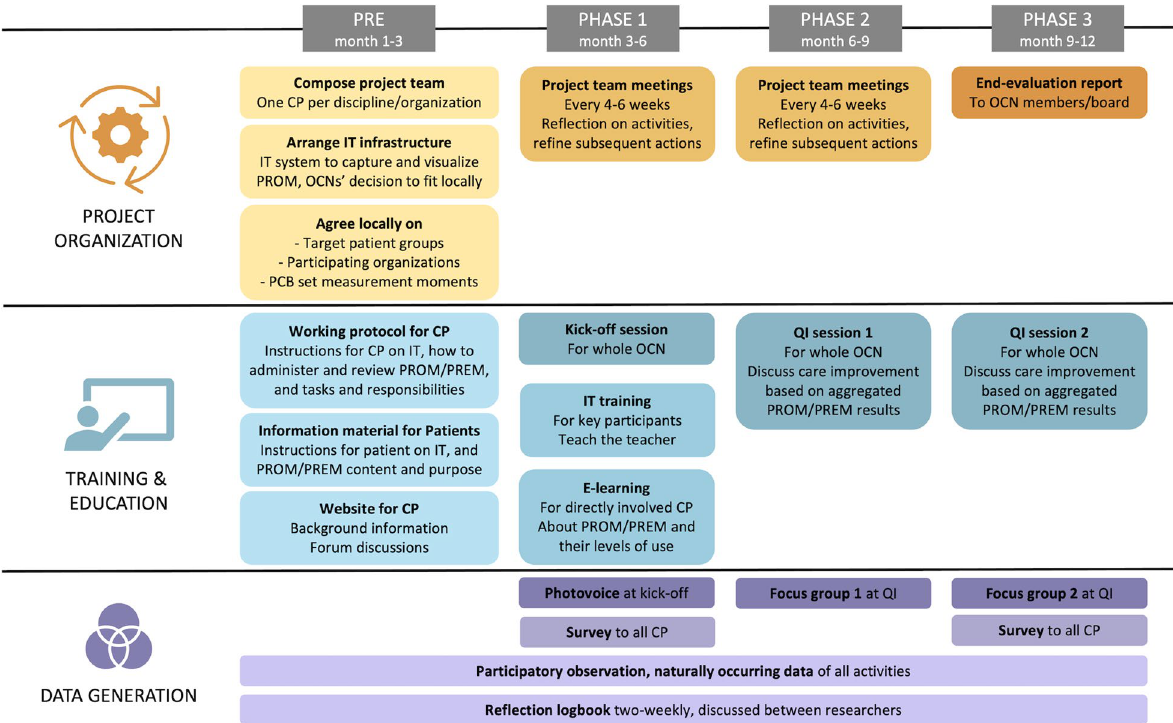
Fig. 1 Timeline of implementation and data generation activities. PROM , patient‑reported outcome measure. PREM , patient‑reported experience measure. QI , quality improvement. OCN , obstetric care network. CP , care professional. VHBC, value‑based